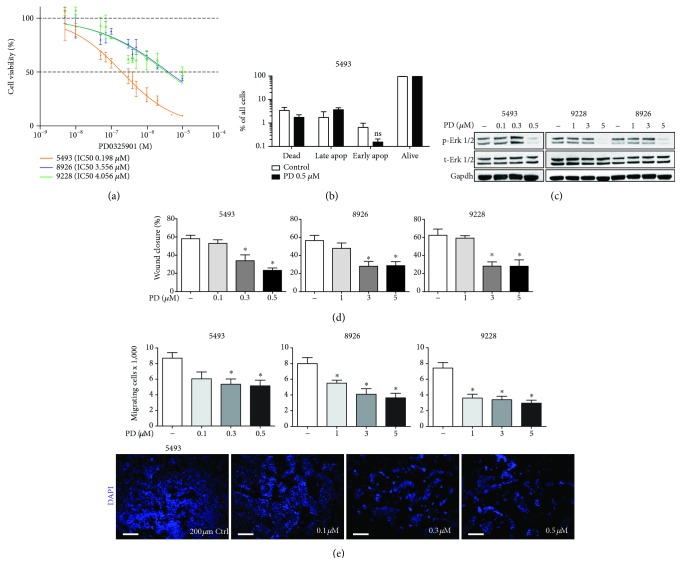
Effect of MEK inhibition on cell viability and migration. (a) MTT assays to determine the respective IC50 for three mouse tumor-derived primary cell lines (5493, 8926, and 9228) treated with PD0325901 (PD). The respective IC50 is depicted for each cell line. (b) Apoptosis induction under MEK inhibitor treatment (3 days) as measured by annexin V staining and analysis by flow cytometry. (c) Western blot analysis for phosphorylated and total ERK 1/2 was performed on the three cell lines treated with PD0325901 at the indicated concentrations. Gapdh was used as a loading control. (d) The percentage of wound closure 24 h after scratch wound induction in primary cells treated with vehicle or PD0325901 at the indicated concentrations. (e) Quantification and representative micrographs (10x, DAPI nuclear staining) of Transwell migration assays with vehicle or PD0325901 treatment with the indicated concentrations. n ≥ 3 for all experiments, n = 2 for Western blot. ∗
P < 0.05 vs. control. ns = not significant.